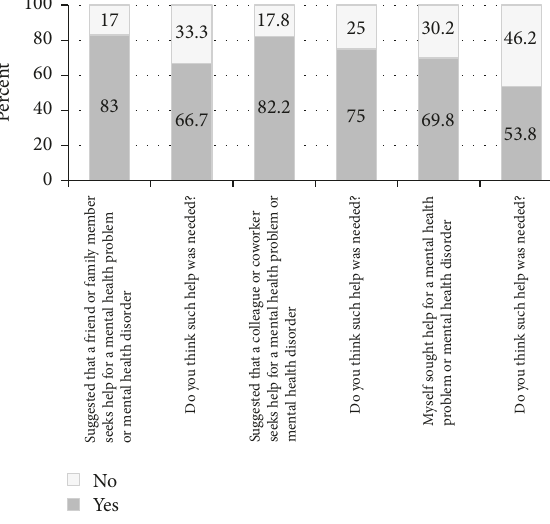
Figure 4: Help-seeking among